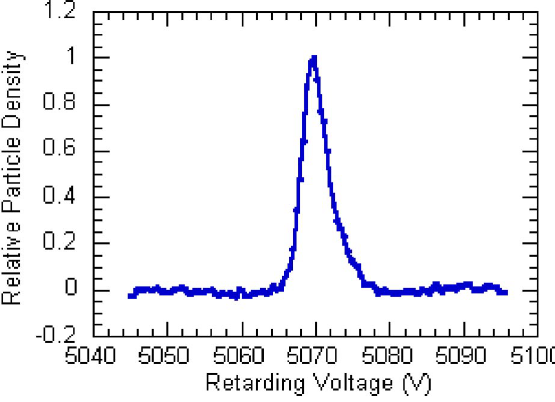
FIG. 8. (Color) Beam energy spectrum for a beam with energy of 5 keV and current of 135 mA. The rms energy spread is 2.2 eV.